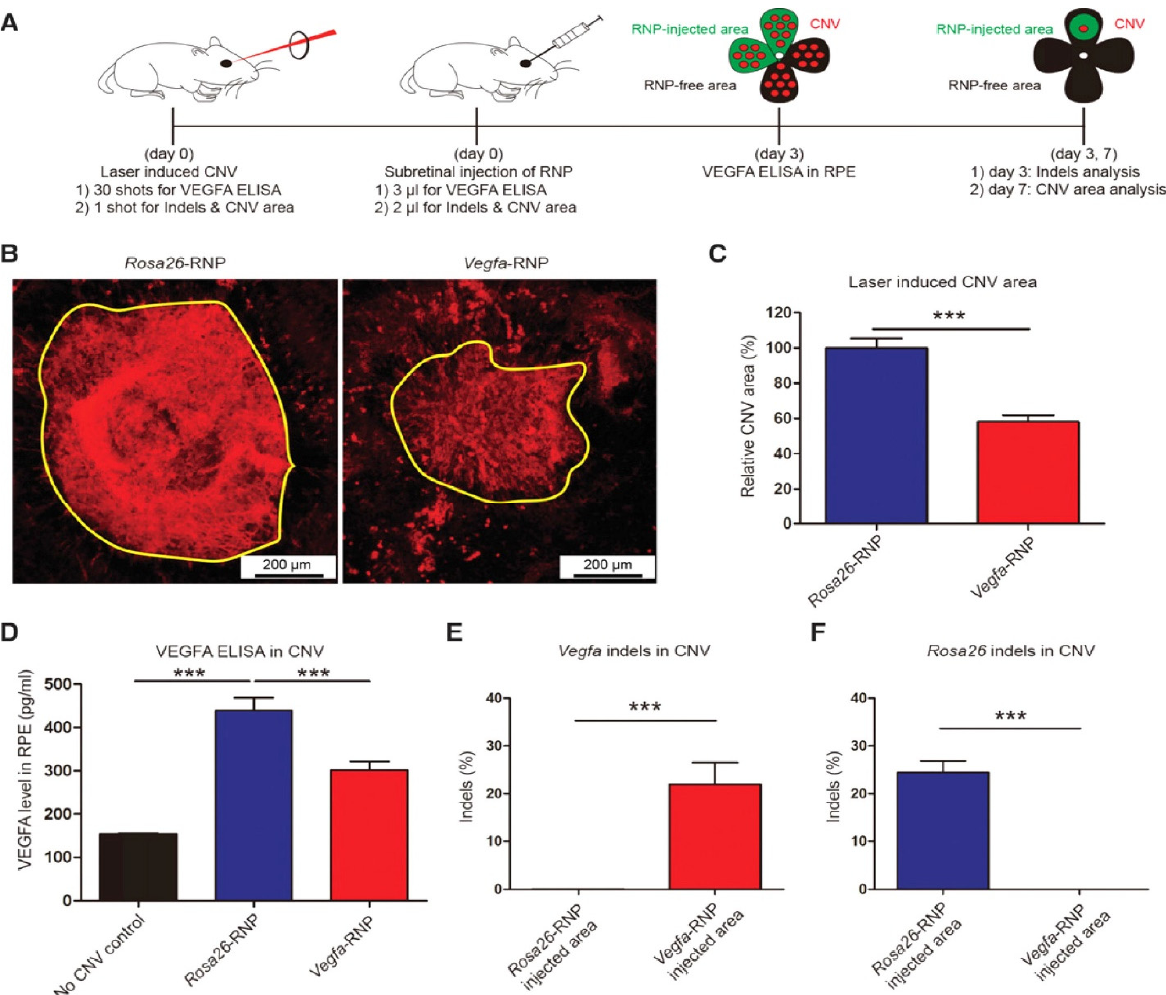
Figure 2. ( A ) Mice with laser-induced choroidal neovascularization (CNV) injected with Vegfa- specific Cas9 RNP analyzed at 3 days post-injection for Vegfa and 7 days post-injection for INDLES analysis. ( B ) The laser-induced CNV was stained with isolectin B4. ( C ) CVN area under Vegfa-RNA. ( D ) controlled and CRISPR/Cas9 edieted comparioson. ( E ) INDEL frequencies due to Vegfa-RNA injected. ( F ) INDEL frequancies at Rosa26 site. Student’s t -test: (***) p < 0.001 [72].